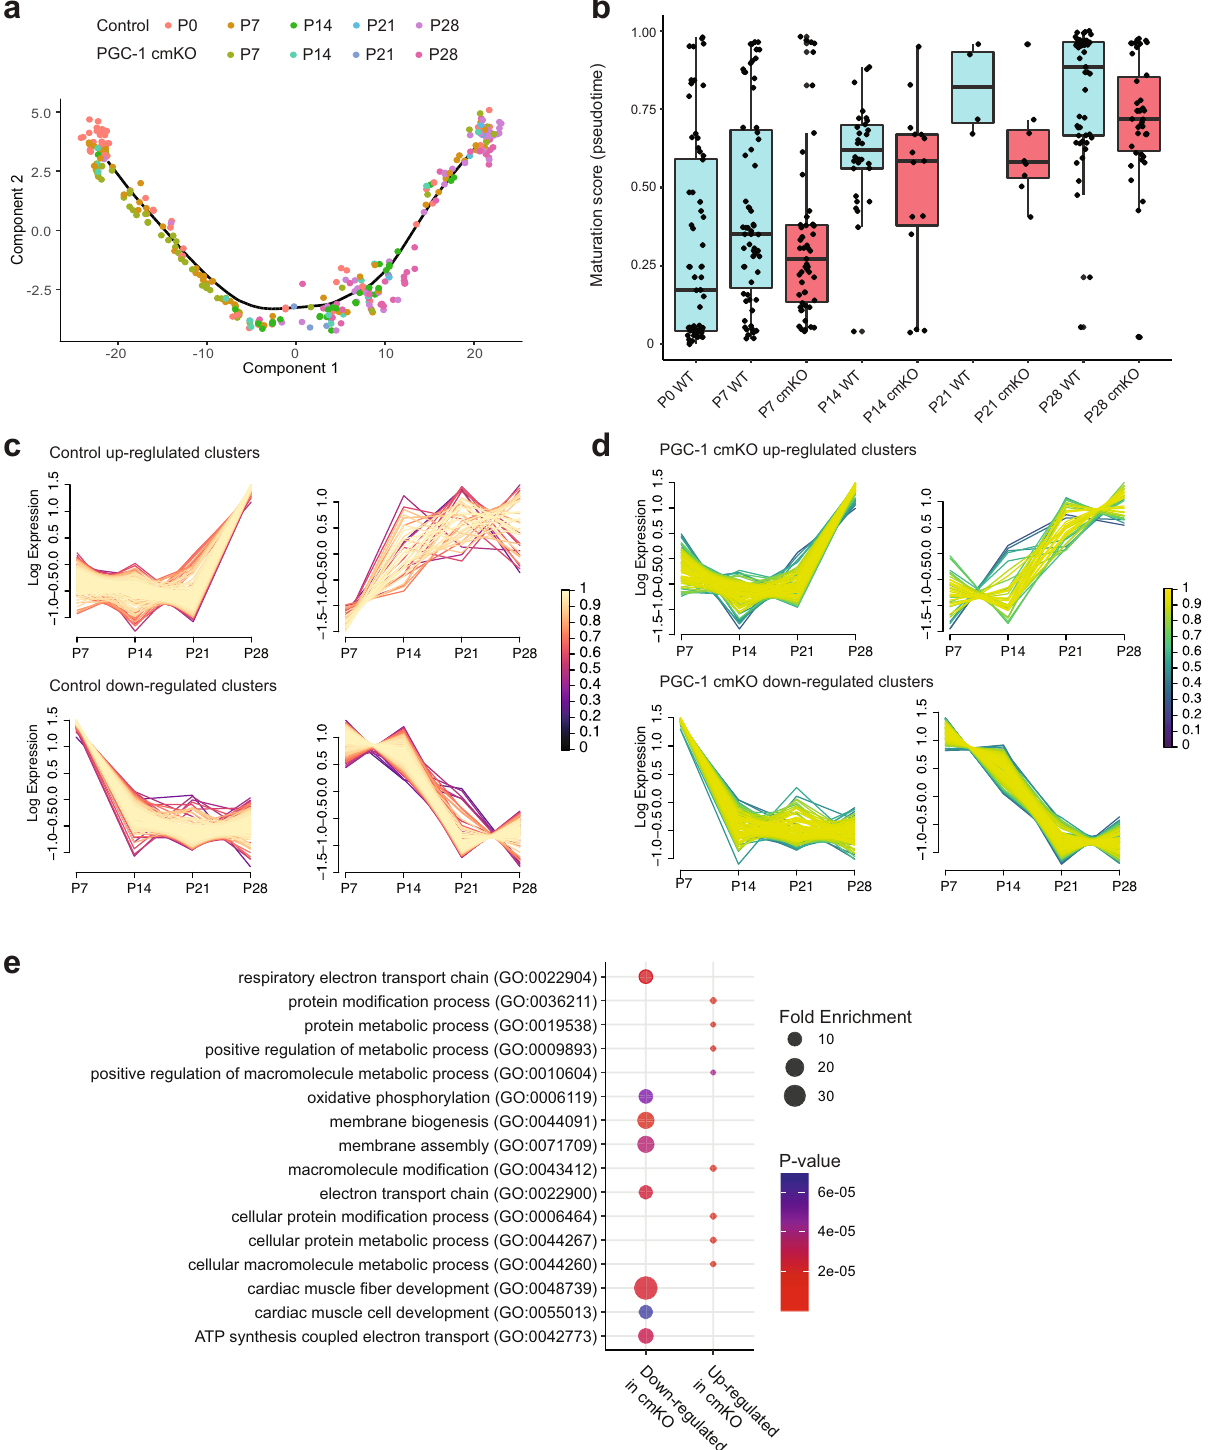
NATURE COMMUNICATIONS| (2021) 12:1648